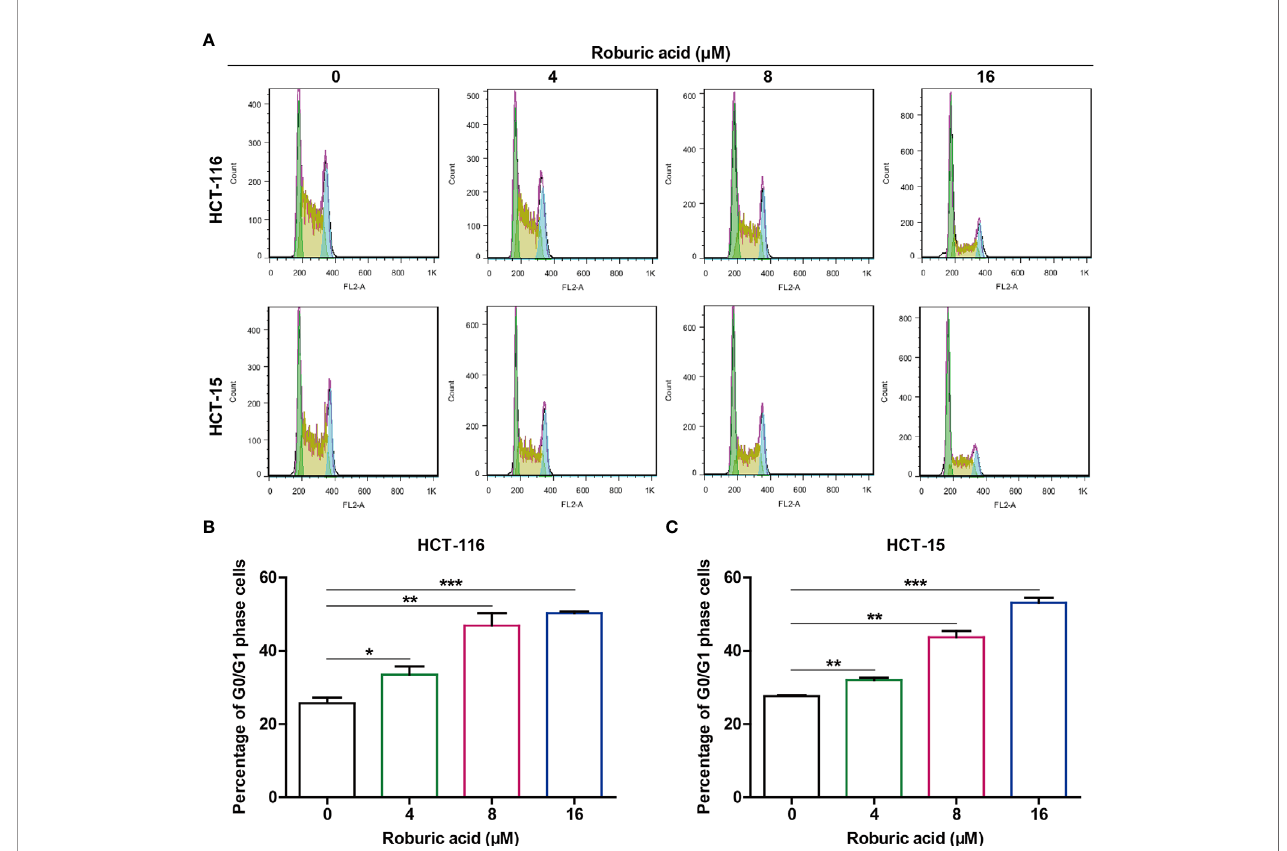
FIGURE 3 | Roburic acid induces G0/G1 cell cycle arrest in HCT-116 and HCT-15 cells. (A) HCT-116 and HCT-15 cells were treated with roburic acid (4, 8, or 16 m M) for 24 h, the cell cycle phase distribution was assessed by BD FACSCalibur fl ow cytometry. (B, C) The percentage of G0/G1-phase cells in HCT-116 (B) and HCT-15 (C) cells was evaluated using FlowJo v.X.7.6.5 software. Representative images are displayed. Data are shown as means ± SEM of three independent replicates. * P < 0.05, ** P < 0.01 and *** P < 0.001 compared with the